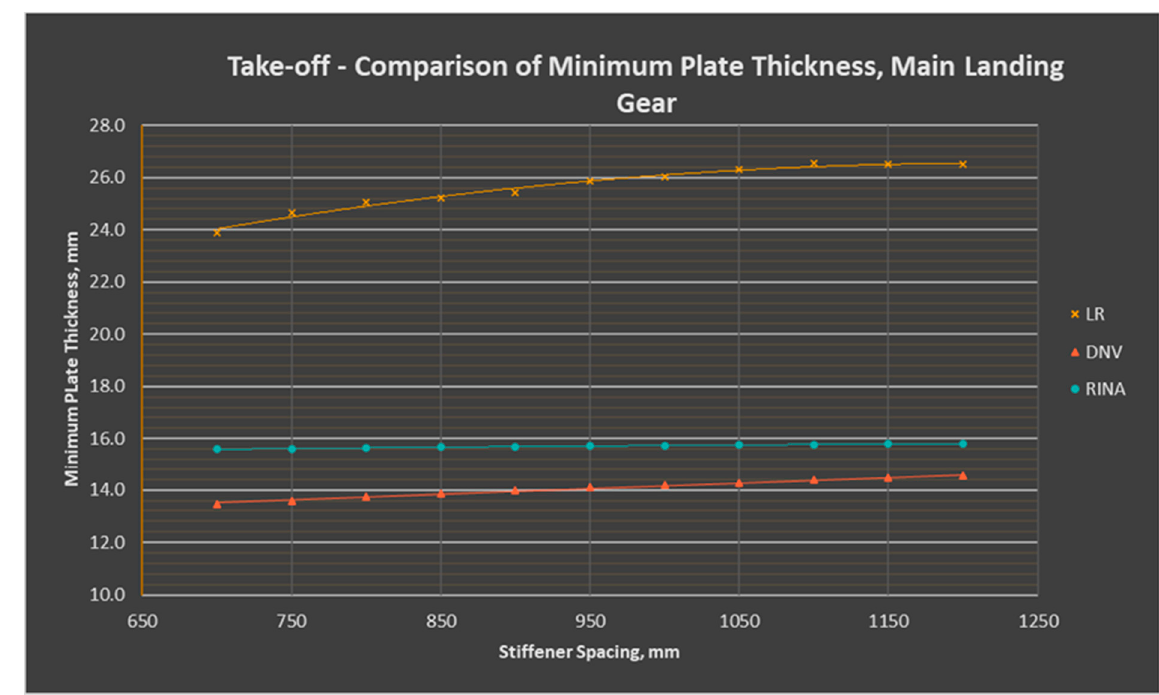
Figure 3. Variations in minimum deck plate thickness as a function of stiffener spacing required for the take-off condition.